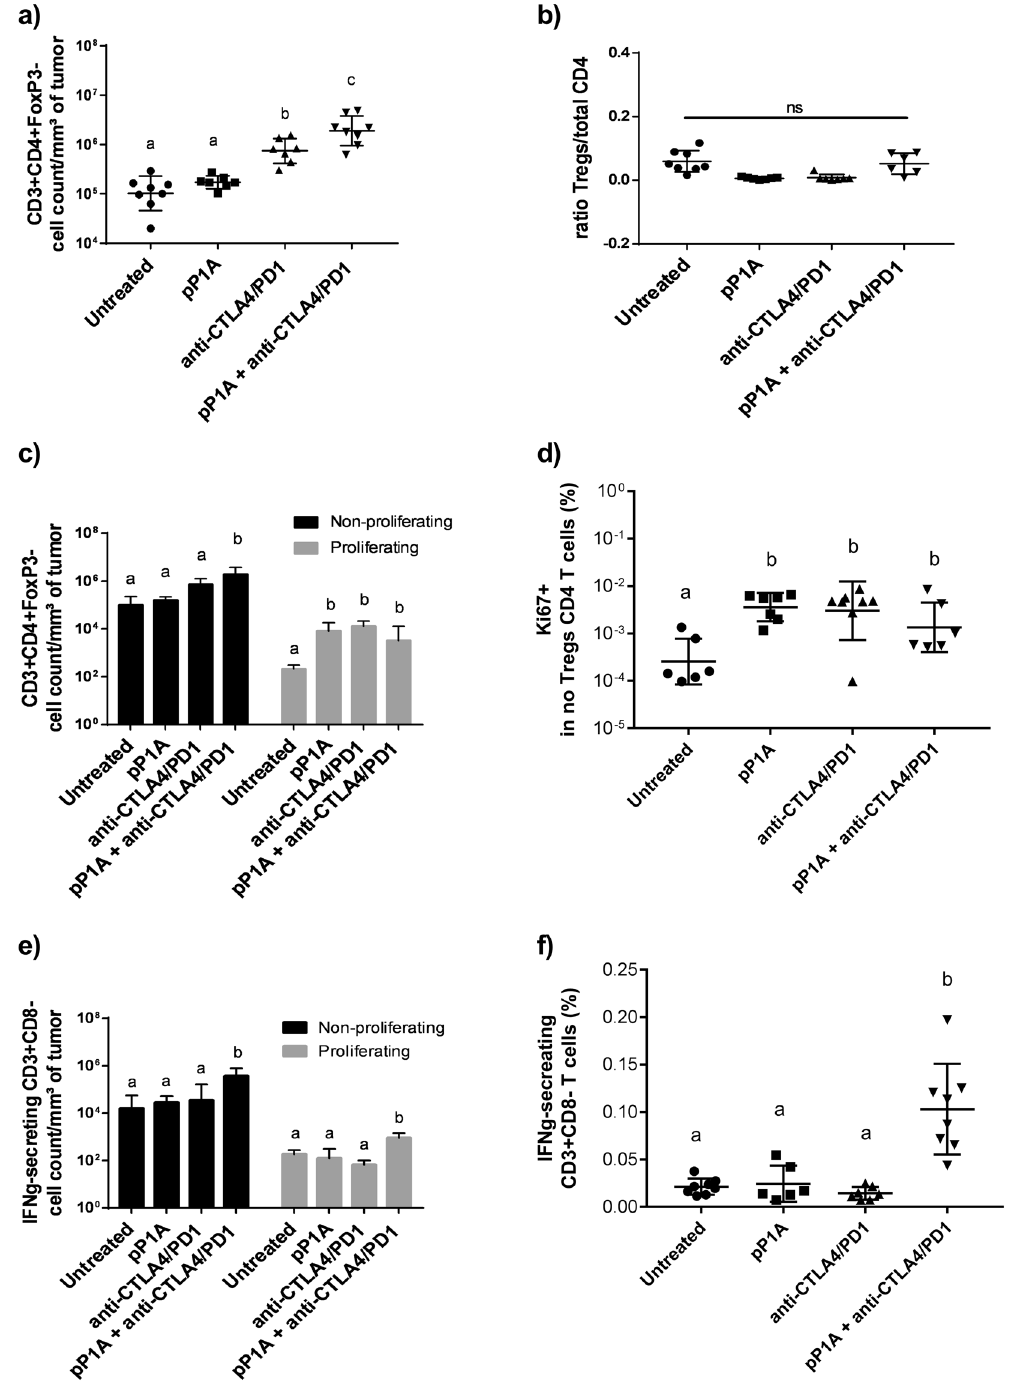
Figure 2. Evaluation of CD4 infiltration in tumors. ( a ) Number of non-Treg CD4 T cells (CD3 + CD4 + FoxP3 − ) per mm³ of tumor. ( b ) Ratio of Treg cells (CD3 + CD4 + FoxP3 + ) compared to the total number of non-Treg CD4 T cells. ( c ) Number of proliferating and non-proliferating non-Treg CD4 T cells per mm³ of tumor. ( d ) Percentage of proliferating non-Treg CD4 T cells per mm³ of tumor. ( e ) Number of IFNg-secreting CD3 + CD8 − T cells per mm³ of tumor. In ( c ) and ( e ), two independent statistical analyses have been performed for non-proliferating and proliferating cells. ( f ) Percentage of IFNg-secreting CD3 + CD8 − T cells per mm³ of tumor. All the results are expressed as the mean ± SD (n = 6–8) and were considered statistically significant when p < 0.05 (indicated by the absence of common superscript letters) according to one-way